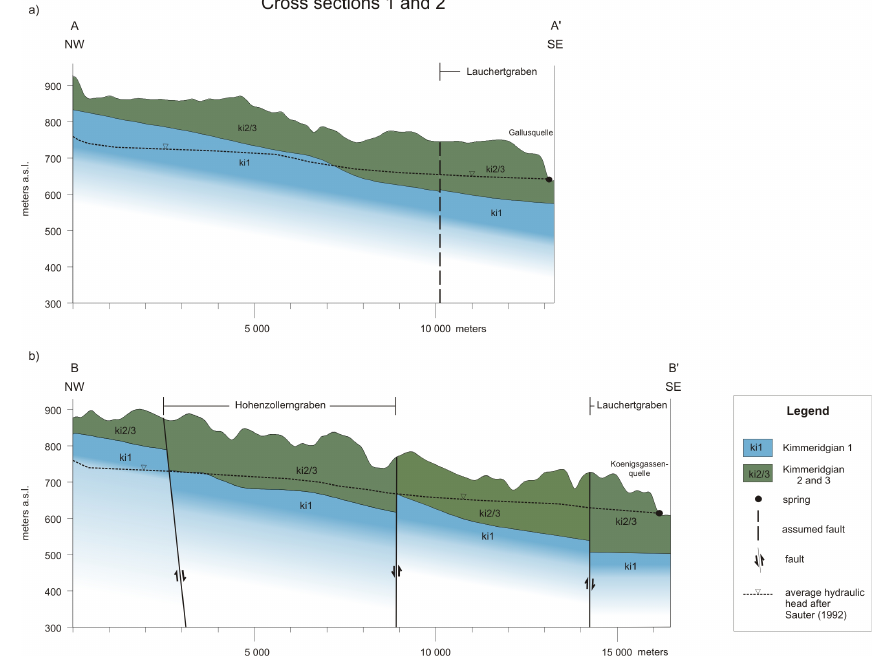
Fig. 4. Cross sections of the study area as constructed in GoCAD ® from northwest to southeast with a vertical exaggeration of 10:1. (a) cross section 1 through the Lauchertgraben and the Gallusquelle spring. (b) cross section 2 through the Hohenzollerngraben, the Lauchertgraben and the Königsgassenquelle